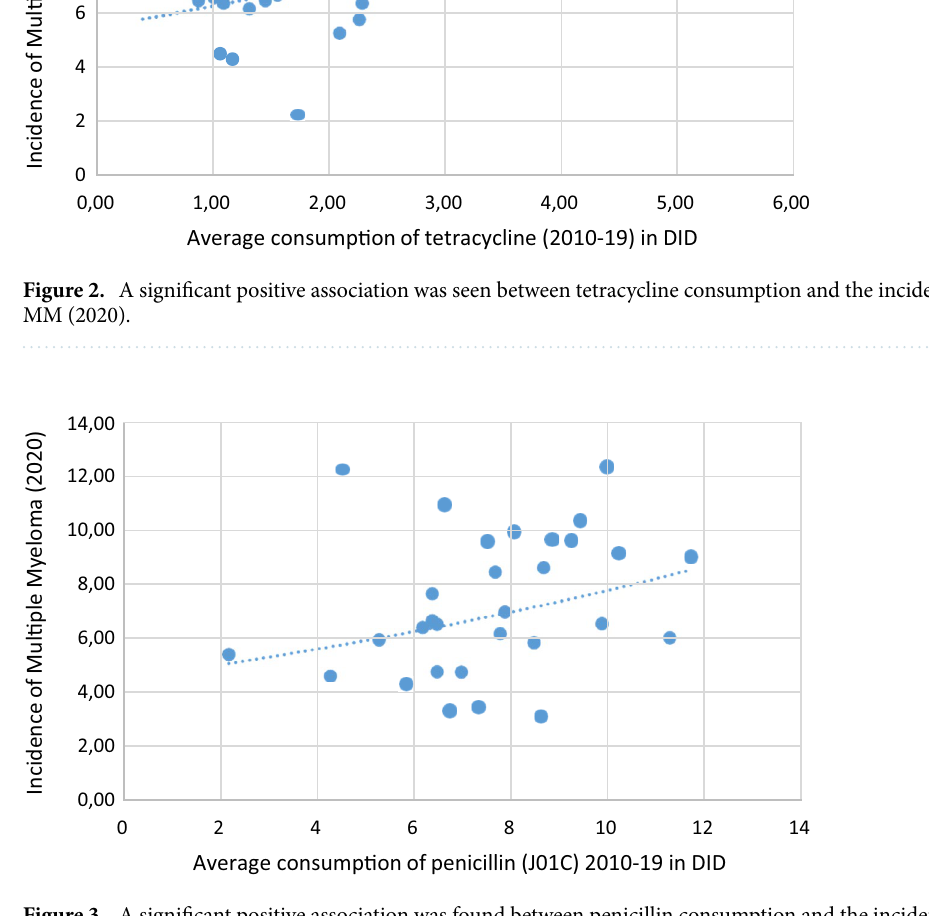
Figure 3. A significant positive association was found between penicillin consumption and the incidence of MM